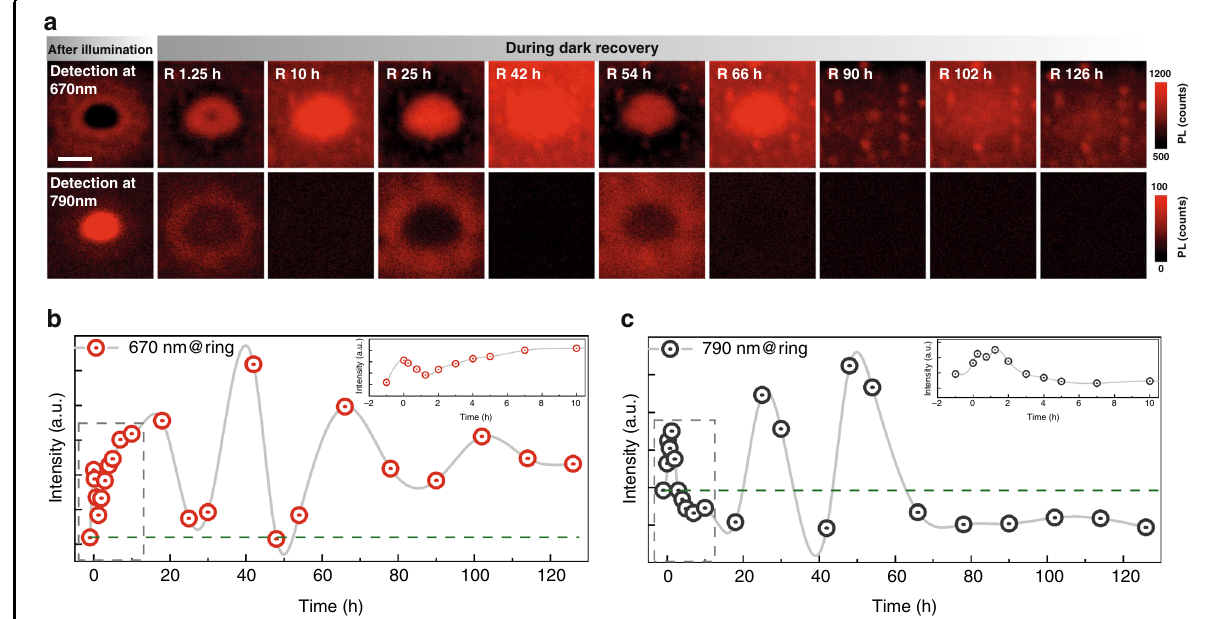
Fig. 5 Oscillatory phenomenon of light-induced ion redistribution. a PL mapping after local illumination and at selected recovery times for 670 nm (top row) and 790 nm (bottom row). The scale bar is 40 μ m. b , c Time-dependent PL intensity taken at the ring in ( a ) for 670 and 790 nm, respectively. Insets show a zoom-in view of the time range before 10